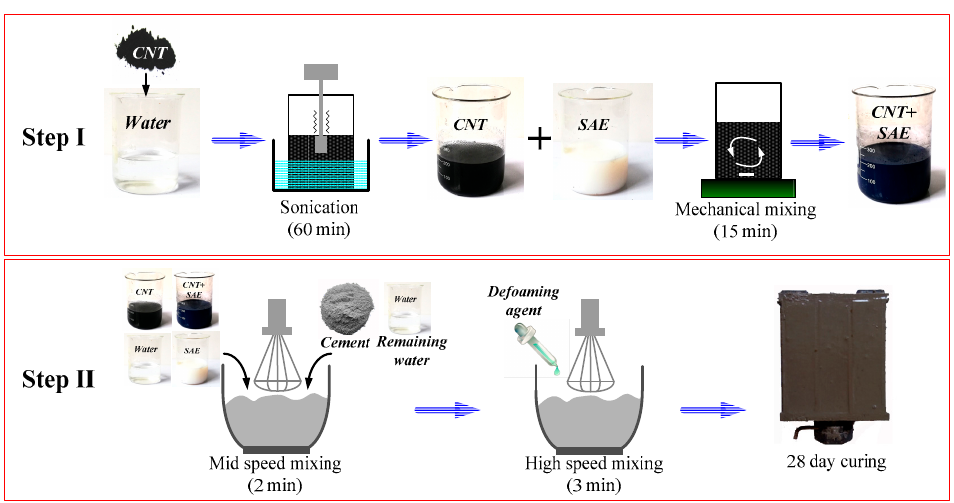
Figure 1. Flow chart of the preparation of the samples.